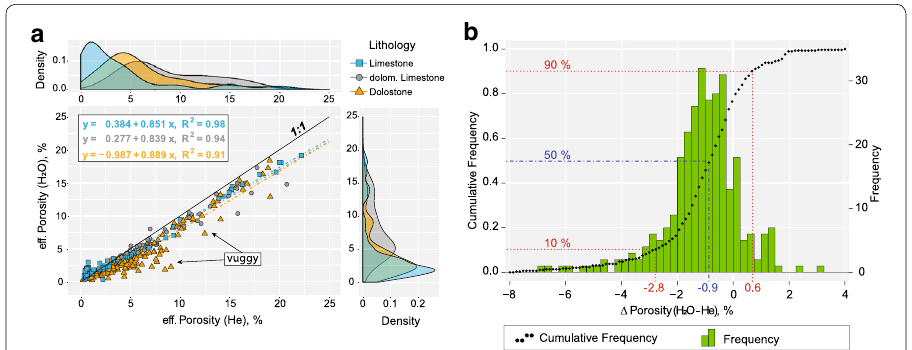
Fig. 17 Comparison of porosity measured by HEP and WIP methods. a φ w eff is directly plotted against φ He eff . Data were separated to control lithology dependency. Density plots show a positively skewed distribution and a high variance of porosity. B: Histogram and cumulative frequency of porosity deviation between both methods (bin width 0.25%). Red dotted lines show 10% and 90% percentiles between which most = deviation values were found. Blue dashed line indicates that 50% of all samples have a deviation of less than—0.9% p.u. and 50% more than—0.9%